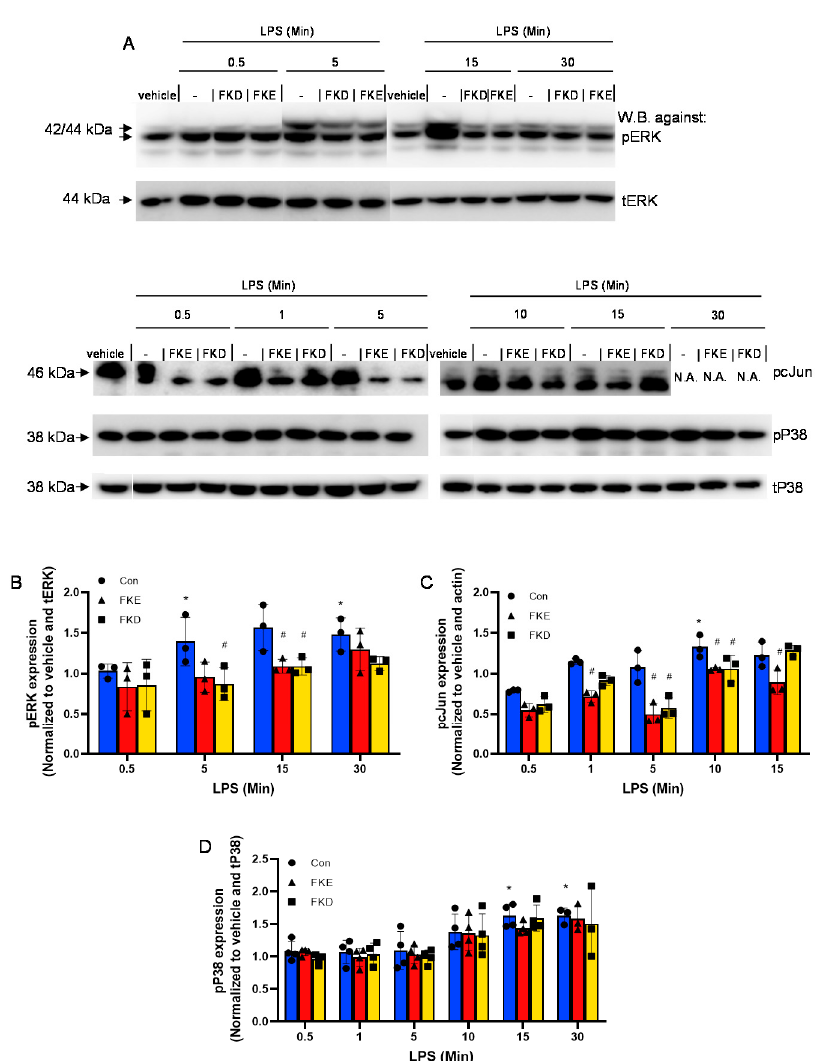
Figure 2. LfP inhibit LPS-induced ERK and cJun activation in human macrophages. U937-derived macrophages were treated with FKE or FKD (10 µ M) for 60 min, and then supplemented with LPS (10 ng / mL). After additional 0.5–30 min the cells were harvested and protein extracts from the cells were run by 10% SDS-PAGE, and blotted for total or phospho-ERK1 / 2, P38MAPK, and cJun using the appropriate primary and secondary antibodies. Results are representative from three experiments ( A ). Time points that showed unequal amounts of total proteins were excised from the presented image. Densitometric analysis for phospho-ERK1 / 2 ( B ), phospho-cJun ( C ) and phospho-P38MAPK ( D ) are depicted following normalization to total ERK, actin, and total P38MAPK, respectively, and to controls / vehicle-treated cells (Con). Results are representative ( A ) and means ± SD ( B – D ) from 3–4 experiments. * p < 0.05 compared to untreated cells, # p < 0.05 compared to LPS-treated cells at the same time (ANOVA).